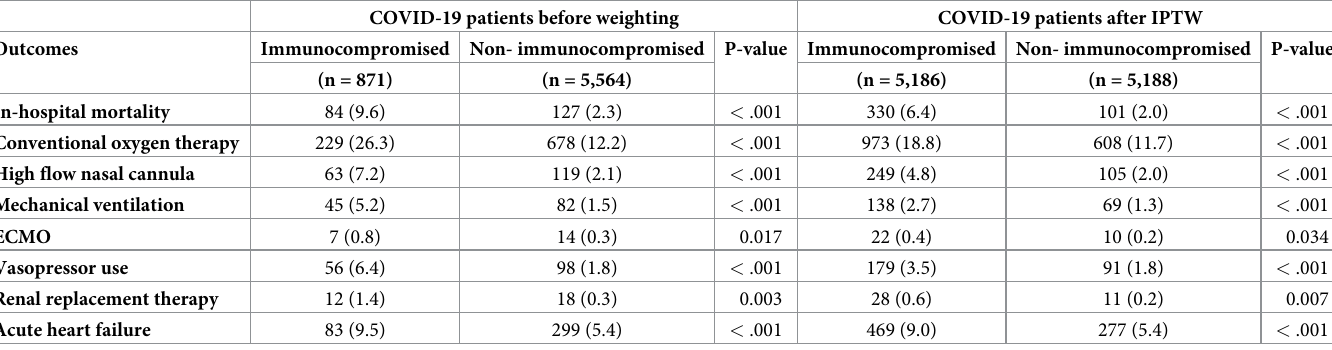
Table 2. Outcomes of patients with COVID-19 according to immunocompromised status.